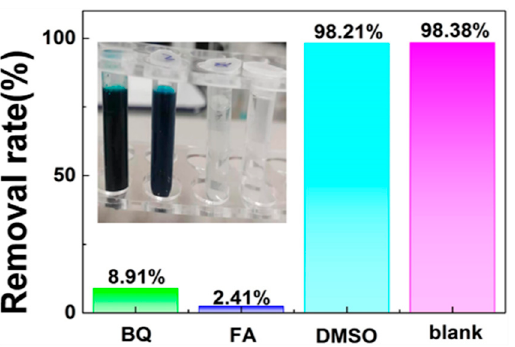
Figure 10. Effects of BQ, FA and DMSO on the photocatalytic degradation rates of MG on ZnO@BC under visible light irradiation.